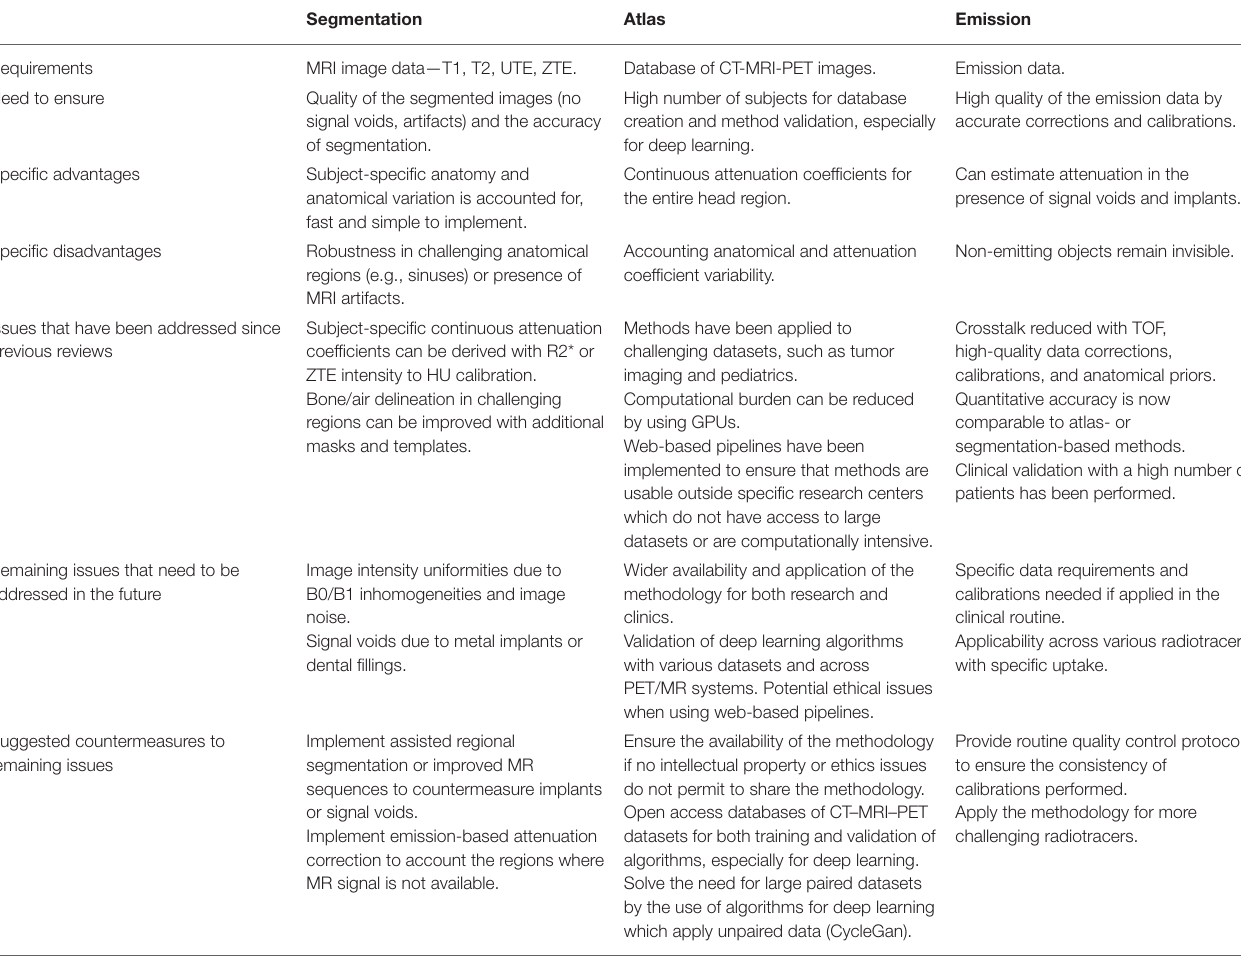
TABLE 1 | Generalized summary of the methodology between (a) segmentation-, (b) template-, and (c) emission-based MRAC methods. Essential concerns, potential solutions, and future directions are